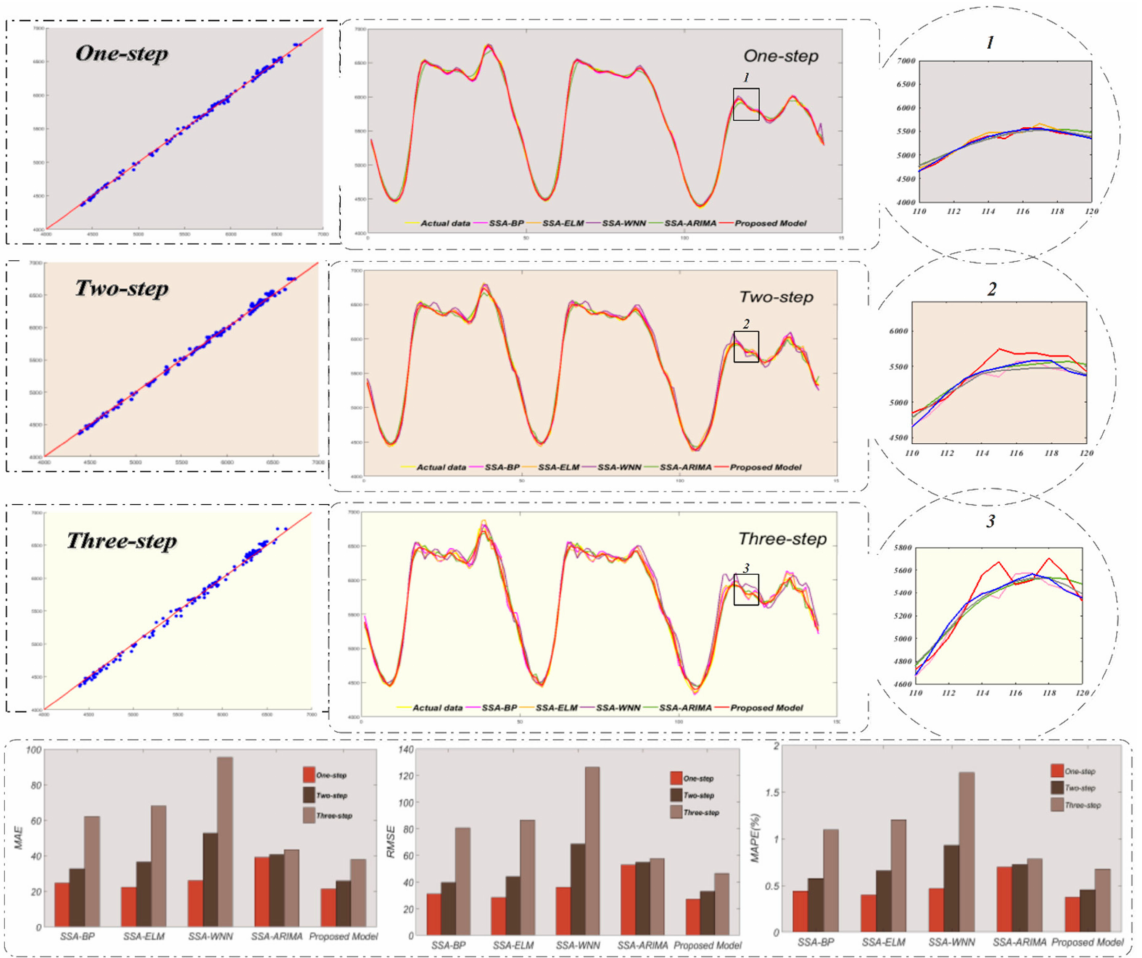
Figure 3. Comparison of multistep forecasting performance of Experiment I in Queensland (QLD;